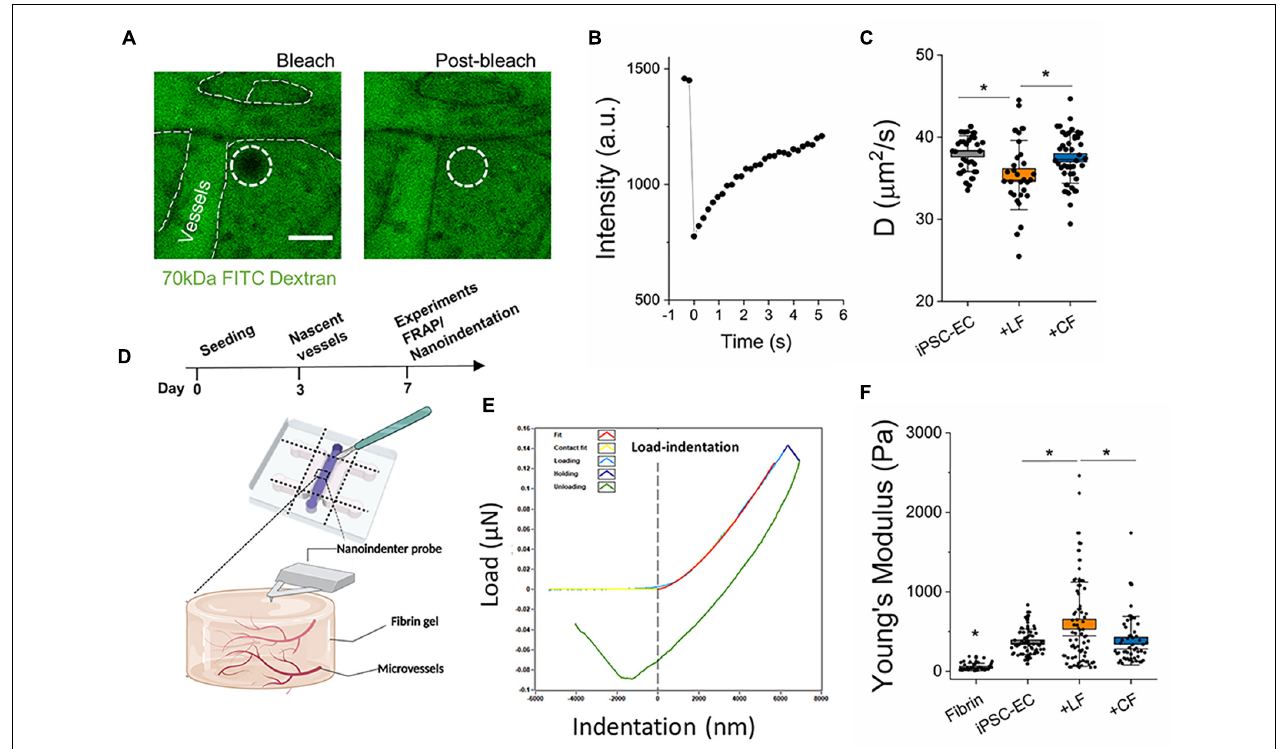
FIGURE 3 | Stromal cells impact extravascular matrix properties. (A) Representative images of FRAP measurements in the extravascular regions performed on day 7. Images show bleached and post-bleached regions—as indicated by the dotted white circle. (B) Example of post-bleach recovery, as measured by fluorescent intensity over time. (C) Diffusivity measurements of the extravascular regions from the different microvessels. (D) Experiment timeline for FRAP and schematic of nanoindentation measurements. (E) A representative load-indentation graph of the gel-microvessel substrate. The vertical dotted line indicates the intersection of the contact point. (F) Measured effective Young’s modulus for Microvessels at day 7. Box plots demonstrate SD (outer whiskers) and SE (box edge). Significance is shown by * P < 0.05, using one-way ANOVA and a subsequent Tukey means comparison